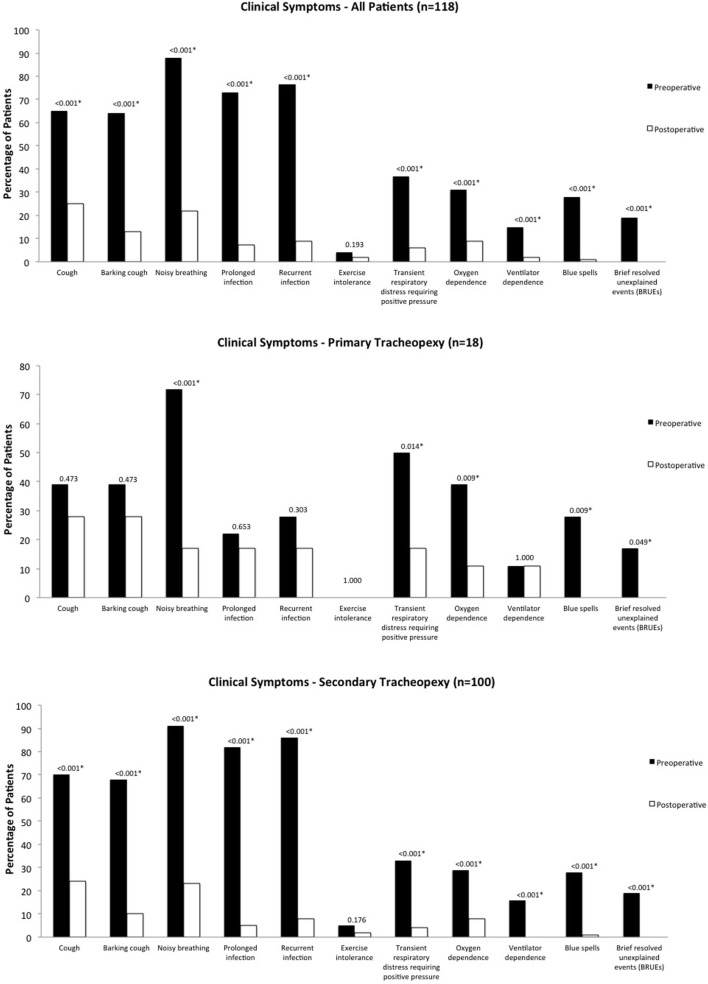
Clinical symptoms. Pre- and postoperative clinical symptoms for the overall cohort, as well as primary and secondary groups.